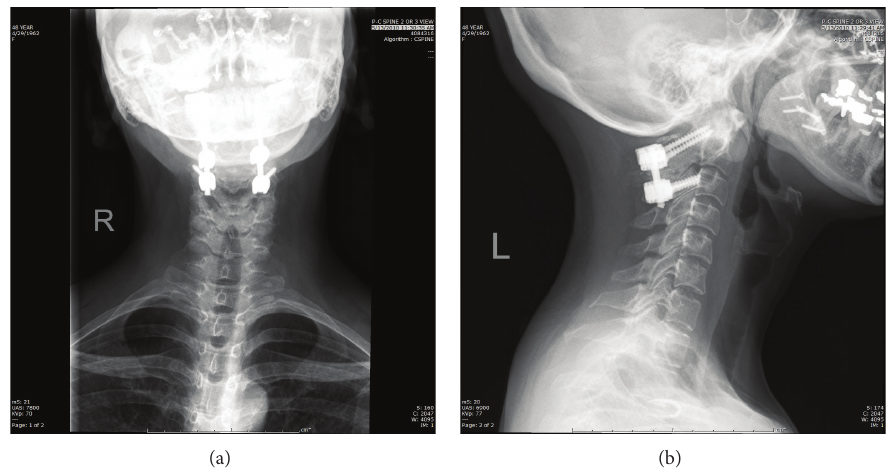
Figure 7: AP (a) and lateral (b) X-rays depicting a C1-2 fusion using C1 lateral mass and C2 pars